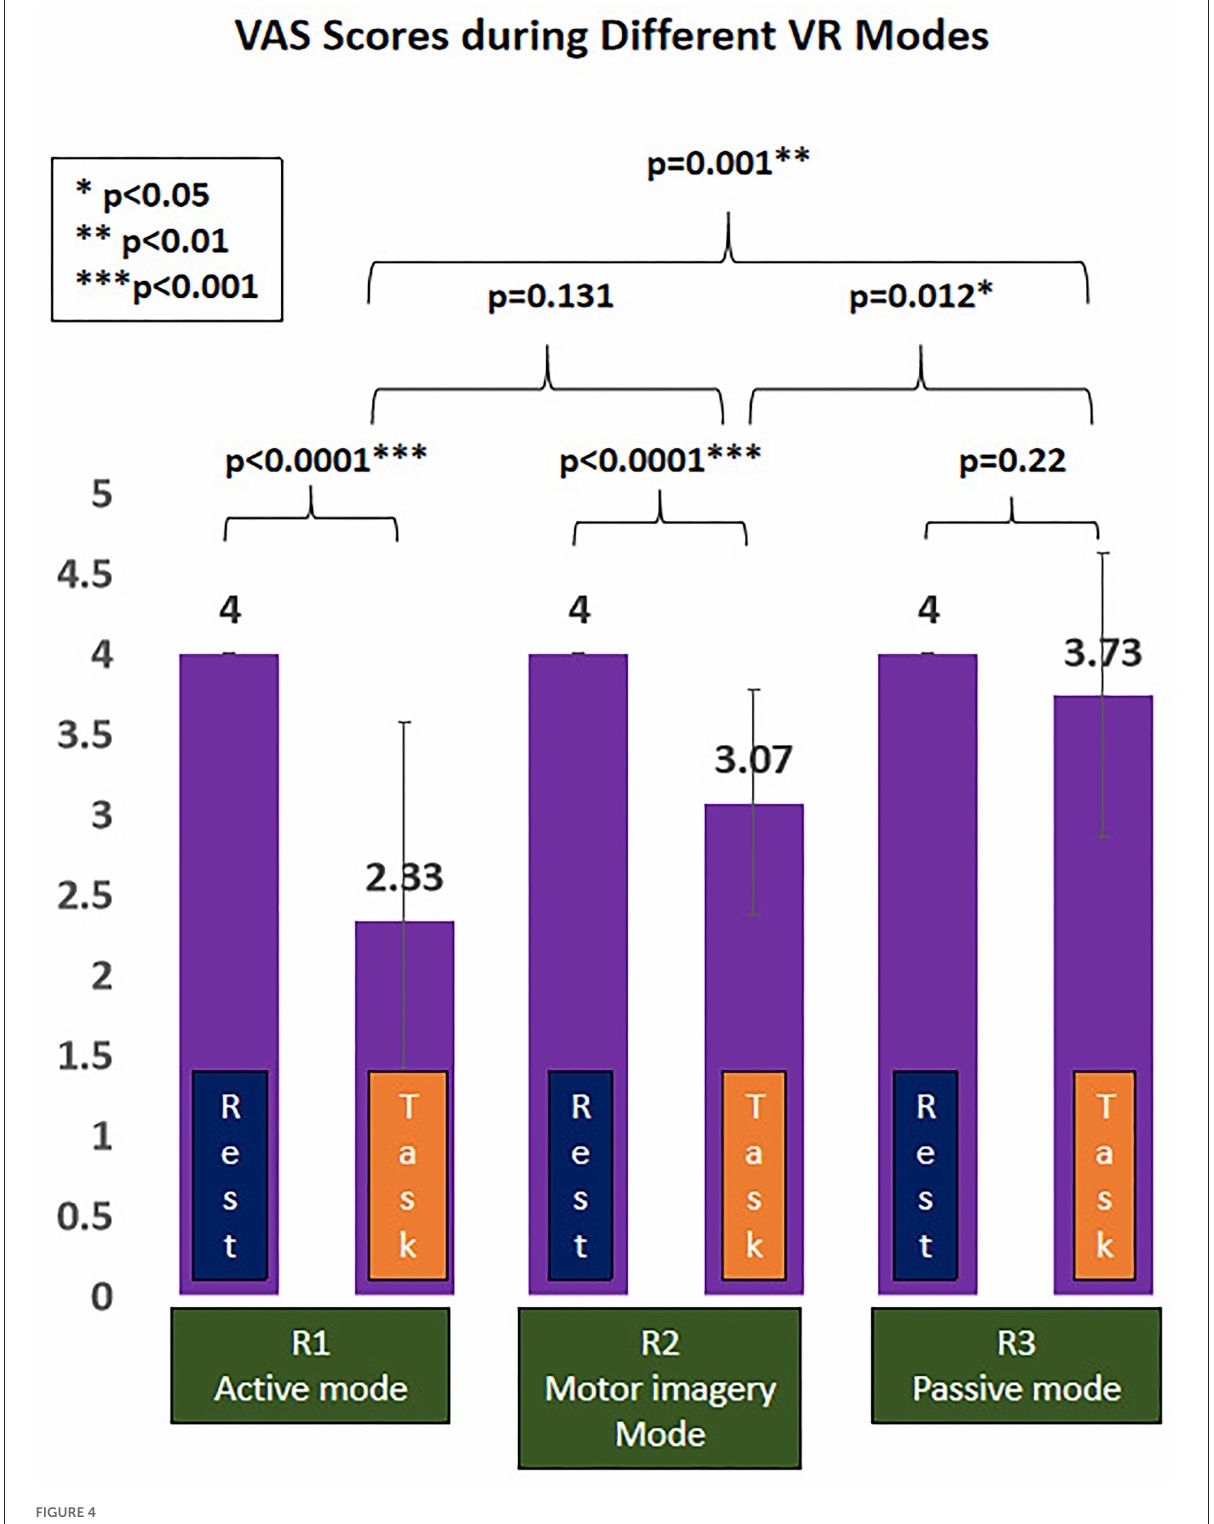
FIGURE4 Virtual reality (VR)-induced analgesic effect during different VR interactive modes. * p < 0.05; ** p < 0.01; *** p <